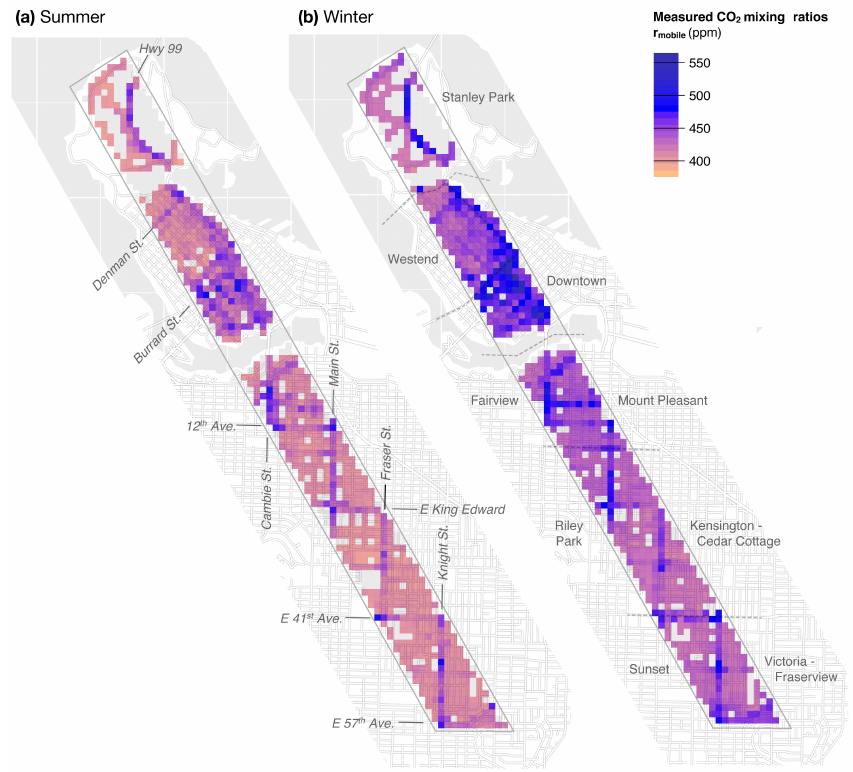
Figure 5. Map of grid-averaged CO 2 mixing ratios ( r mobile ) for (a) summer and (b) winter campaign using the same scale. The grid size is 100 ×